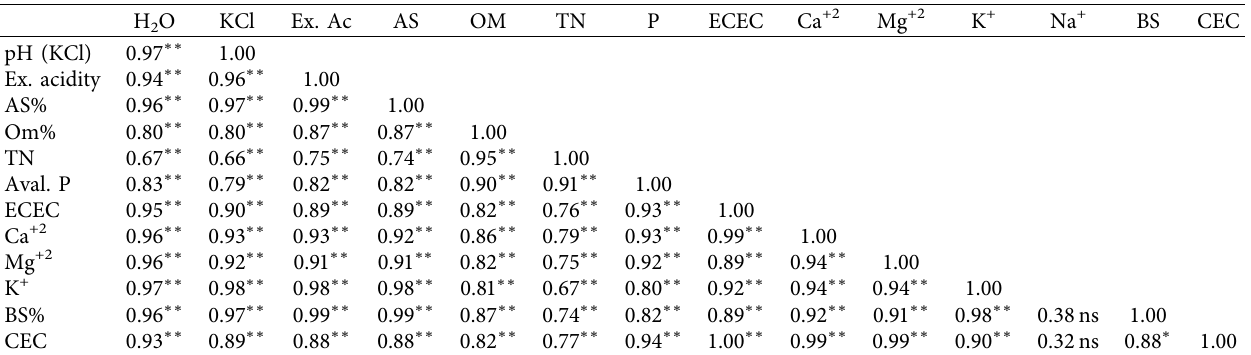
Table 6: Pearson correlation coefcient ( r ) between soil acidity and other soil properties ( N � 24). H 2